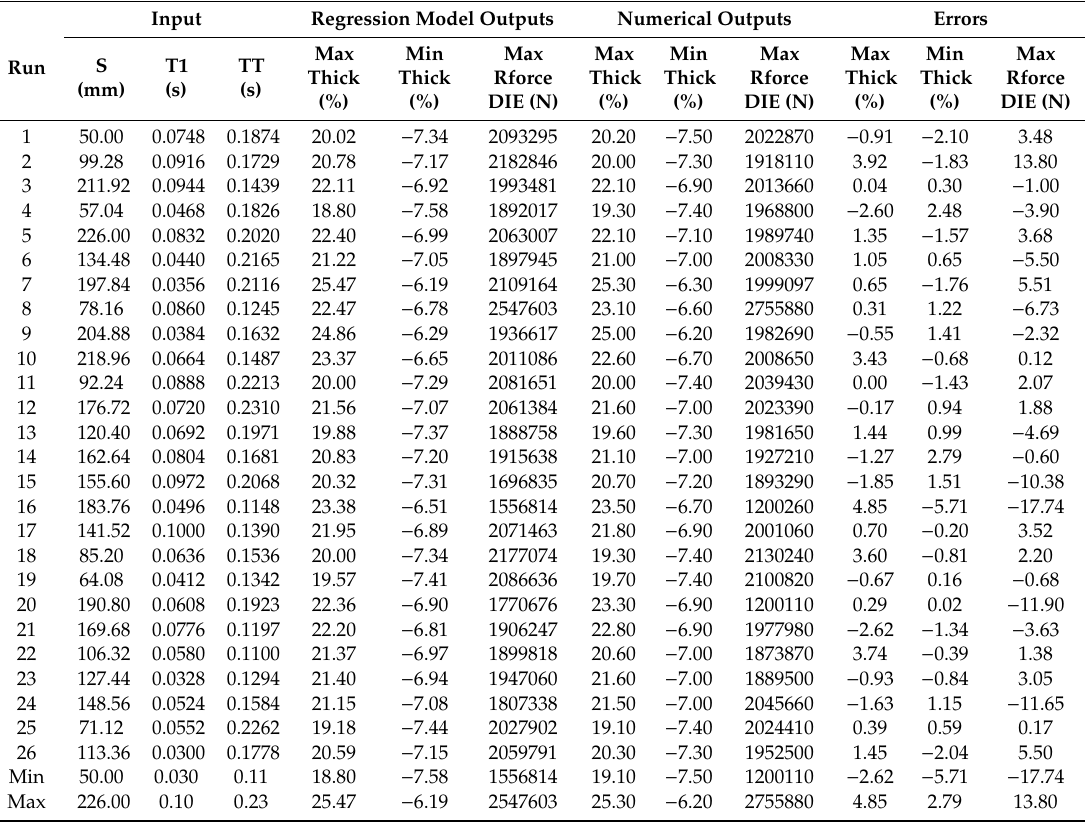
Table 6. Numerical and regression model values correlation for the blank0